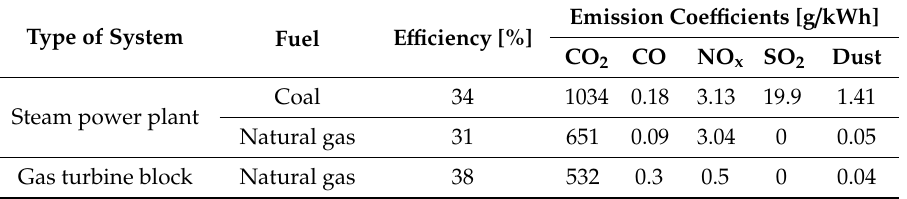
Table 2. Comparison of systems using di ff erent fuels in terms of emissions of greenhouse gases and air pollutants